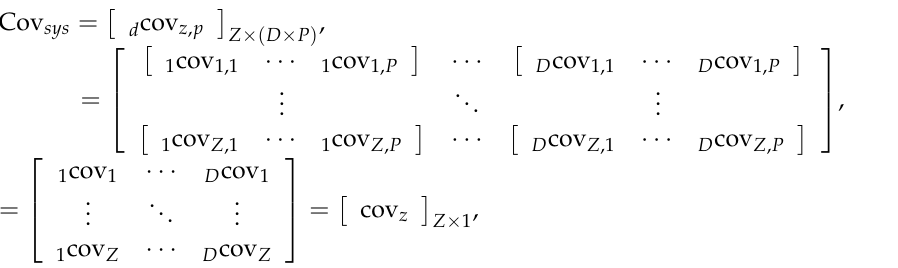
(cid:2) (cid:3) · · · is a 1 × D row vector with D = 2 D cov z 1 cov z